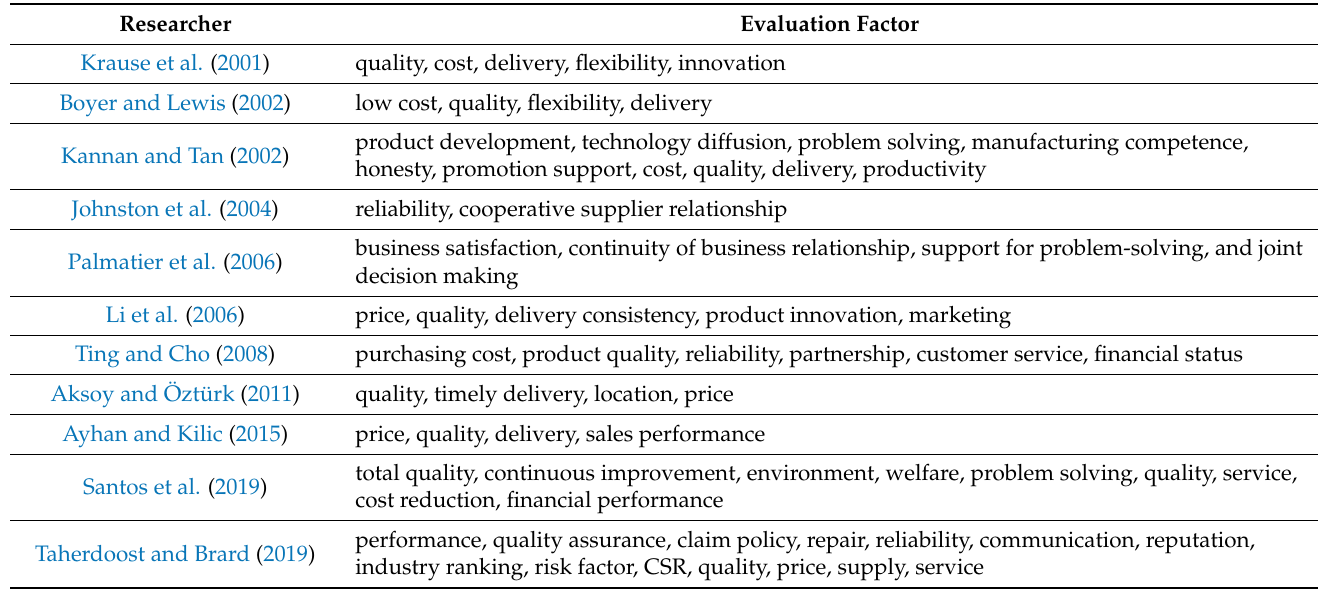
Table 1. Suppliers’ competitiveness factors affecting selection of